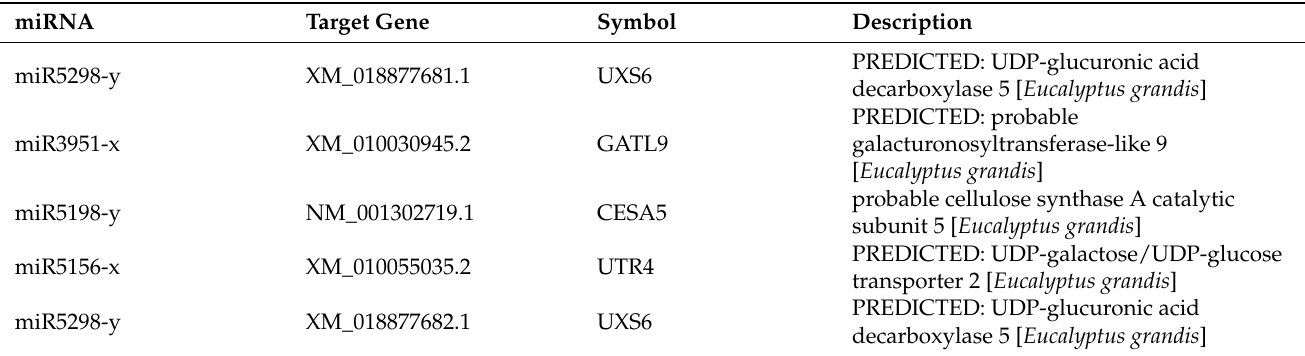
Table 2. Synthesis of Eucalyptus grandis cellulose related